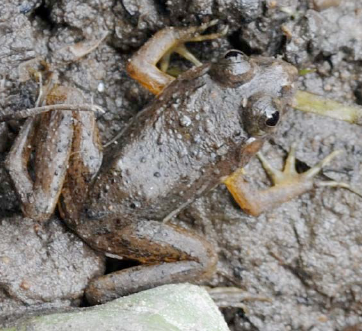
Image 2. Euphlyctis cyanophlyctis , Gelephu. © Dorji Wangchuk